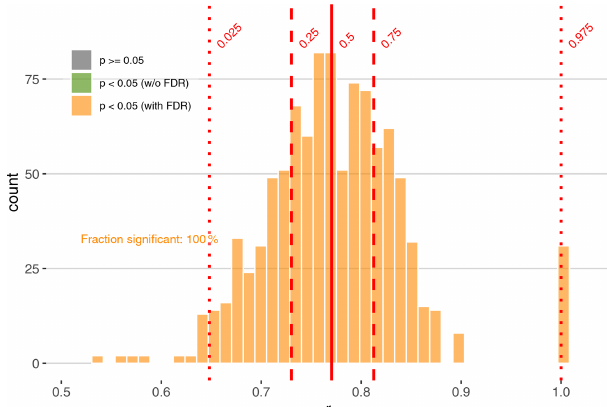
Figure 5. Distribution of age-uncertain correlation between Hulu Cave speleothem δ 18 O and itself, treating the age uncertainty as if it was independent. Conventions are as in Fig.